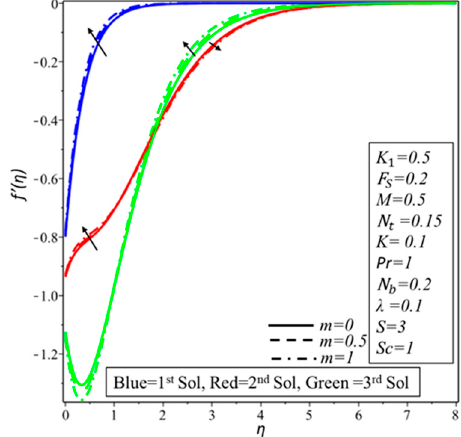
Figure 6. Profiles of the velocity for increasing values of λ .